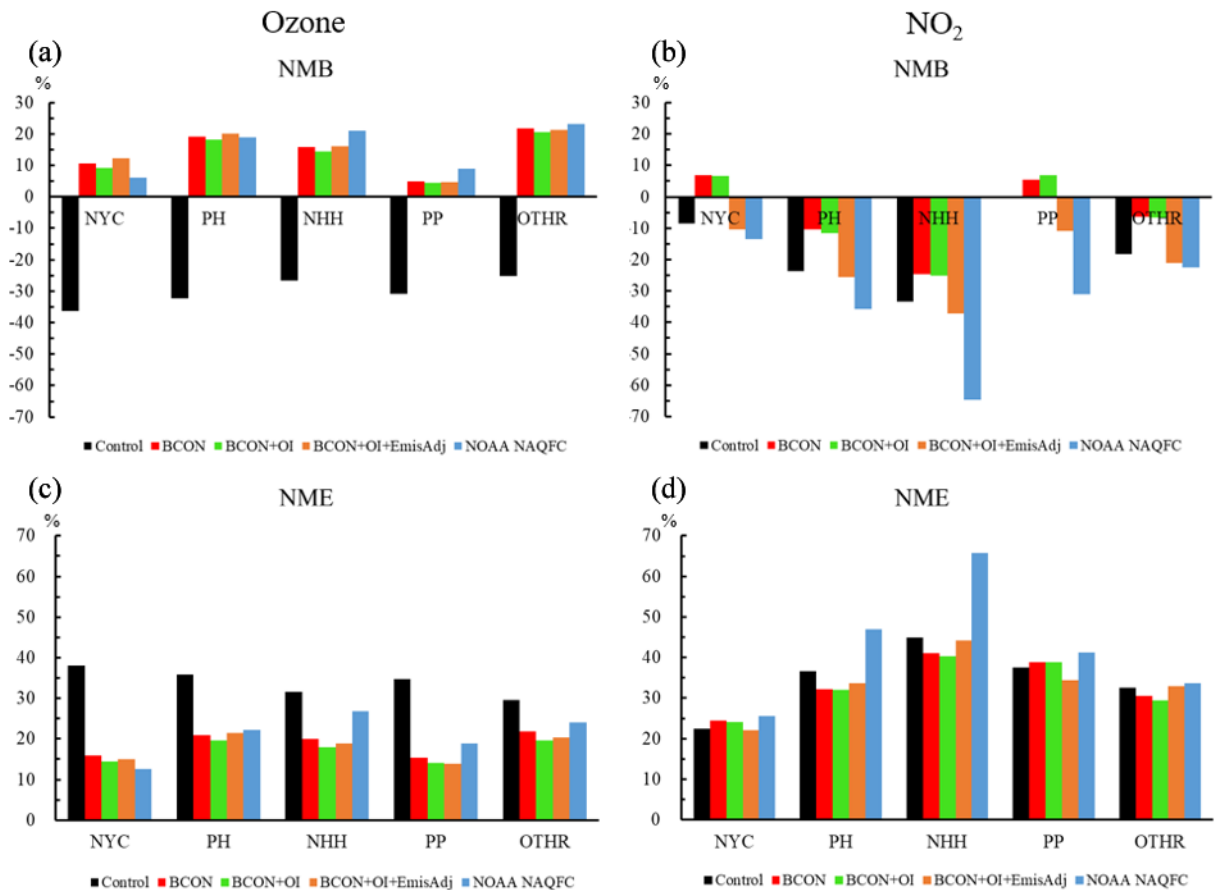
Figure 9. Comparisons of model performance for surface O 3 ( a and b ) and NO 2 ( c and d ) concentrations from five CMAQ simula- tions against measurements from the Air Quality System monitors. These simulations include the Control run, dynamic boundary con- ditions (BCON), boundary conditions with optimal interpolation (BCON + OI), and an all-adjustment run including emission adjustment (BCON + OI + EmisAdj), and the operational NOAA National Air Quality Forecast Capability (NAQFC) run during the episode over five subdomains. Two performance metrics are used here: normalized mean bias (NMB) and normalized mean error (NME). The comparison time is from 26 to 31 August 2018.